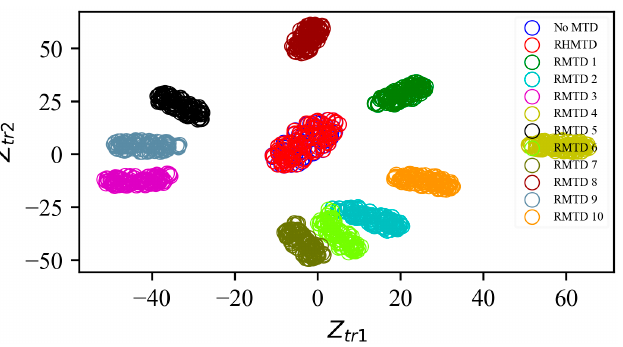
Figure 10. The projection of RHMTD, 10 RMTD, and no MTD measurements in the ℝ 2 space.